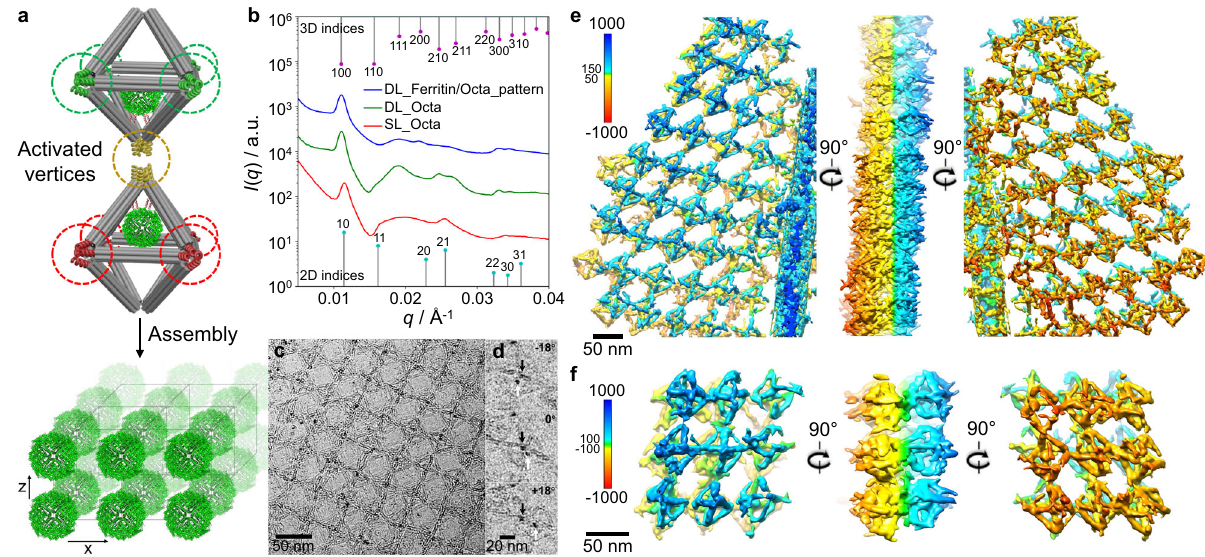
Fig. 4 Ferritin assembly in a double-layered lattice. a Schematic view showing a 2D double-layered (DL) protein/Octa lattice formed by a three-color vertex encoding system consisted of encoded Octa frames with fi ve activate vertices and three sets of complementary DNA pairs (red, green, and yellow). Protein voxel with off-centered ferritin (Off2) was used as discussed in the text. b SAXS pro fi les (shifted vertically for clarity) of the DL empty Octa and ferritin/Octa lattices show co-localization of ferritin and the Octa lattice by the reduced intensities attributed to the ferritin core. The formation of a DL structure was supported by the emergence of broad peaks at the 3D indices of a simple cubic lattice, indicating a layer in the z direction. c A cryo-ET image of a DL lattices. d Representative cryo-ET images showing the two ferritins in the top and bottom layers at tilted angles (black and white arrows) in a DL lattice, which agreed with our design. e , f Cryo-ET 3D reconstruction of DL ferritin/Octa lattice without averaging. The 3D density maps showed the encapsulated ferritin overlaid well with the DL lattice ( e selected lattice area and f representative views, see the text and “ Methods ” section for details). The ferritin positions in f were indicated by the black arrows in Supplementary Fig. 32d. The color bars indicate Z height (unit: Å).